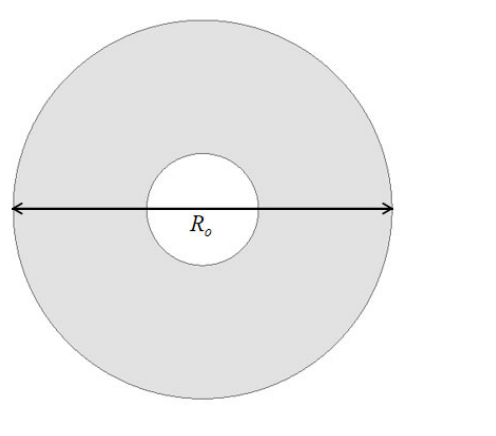
Figure 4. Schematic diagram of IPMSMA. Table 2. The basic parameters of IPMSMA. Parameter